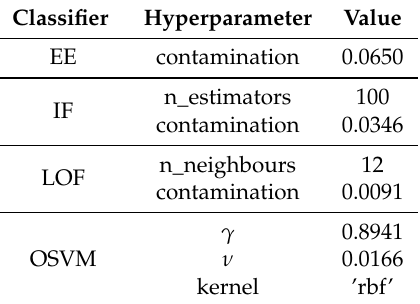
Table 6. Optimised